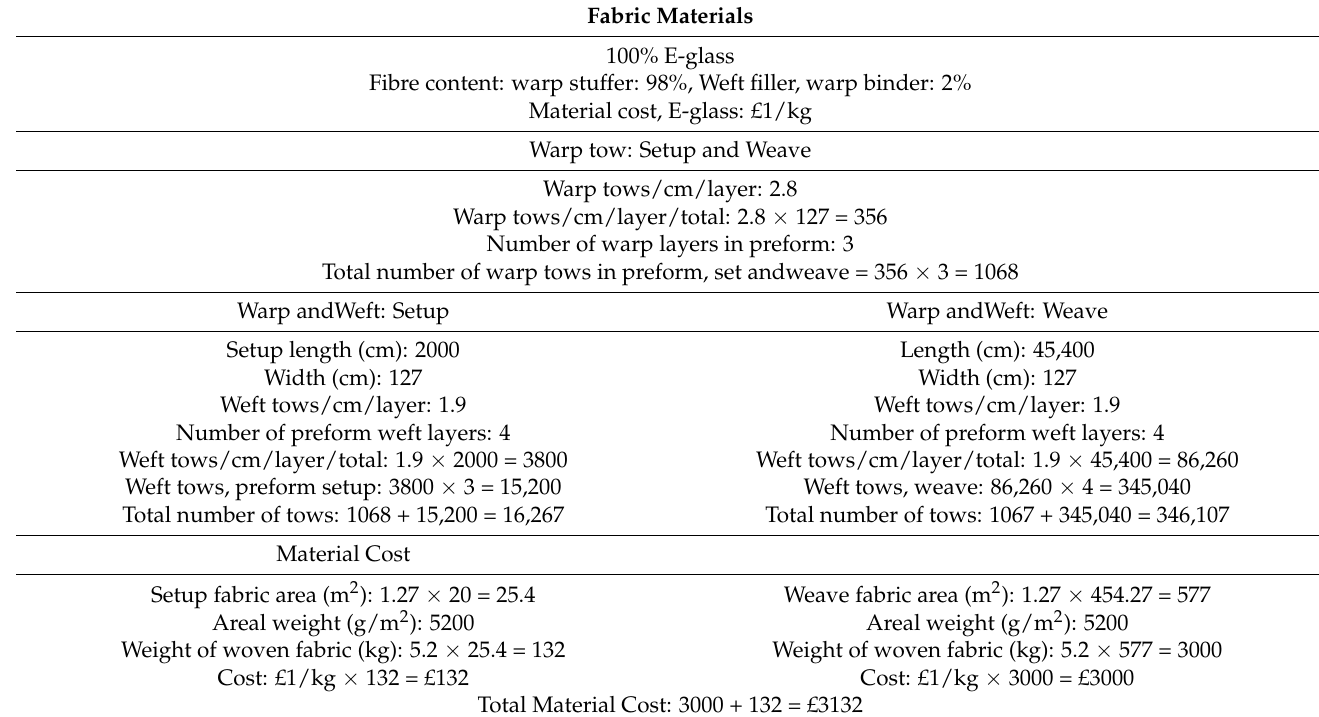
Table 5. Hypothetical 3D woven preform